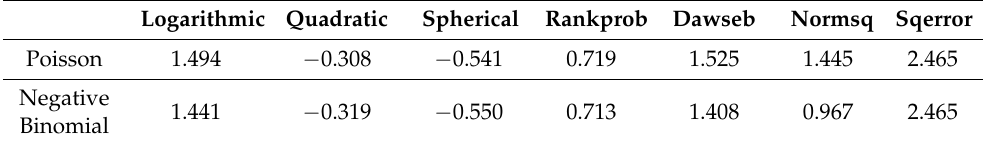
Table 4. Comparison between Poisson and NB Model in Nantung direction. Logarithmic